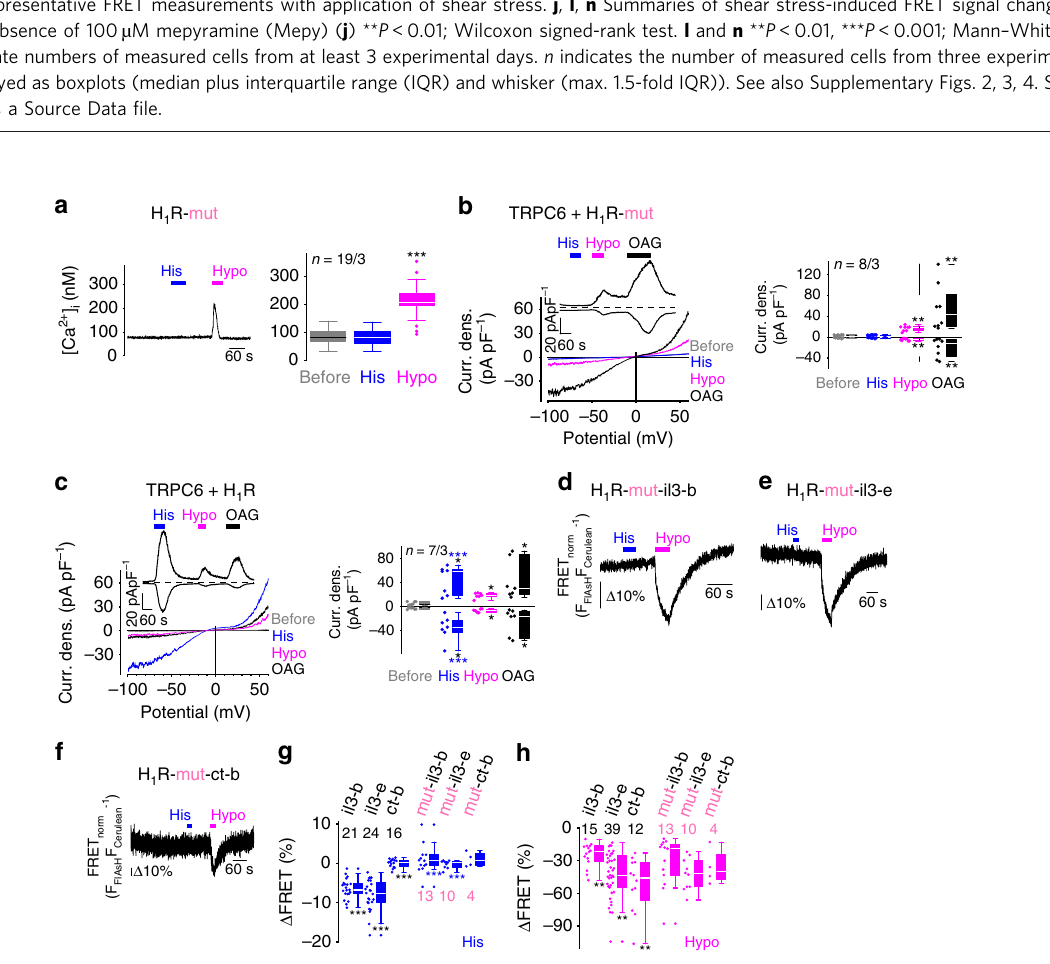
Fig. 3 Mechanical H 1 R activation is independent of agonist binding. a Calcium imaging of fura-2 loaded HEK293 cells overexpressing H 1 R with two amino acid exchanges (D116A and F433A; H 1 R-mut) resulting in disruption of histamine binding. Representative trace of [Ca 2 + ] i with applications of 100 µ